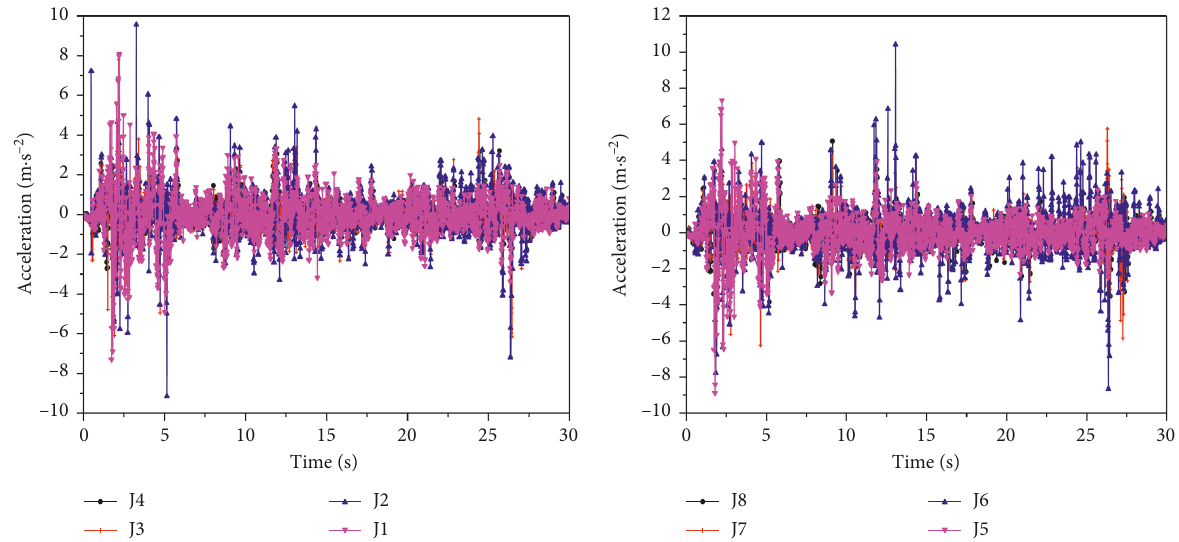
Figure 6: Acceleration of soil under the 0.5g El Centro seismic wave. Table 6: Information of monitoring location.